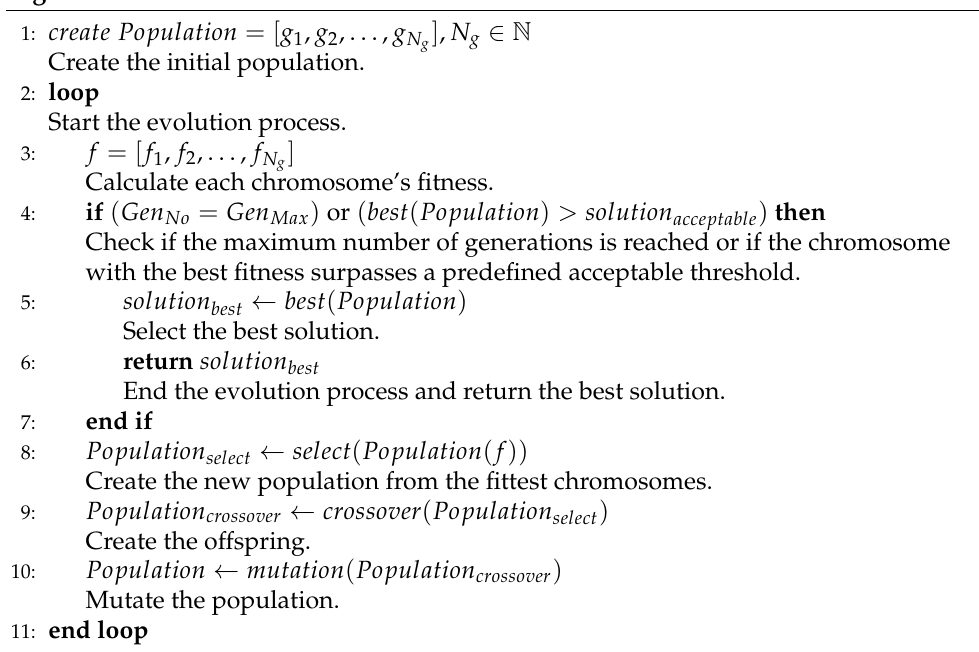
Algorithm 1 The FSC4RBF Method